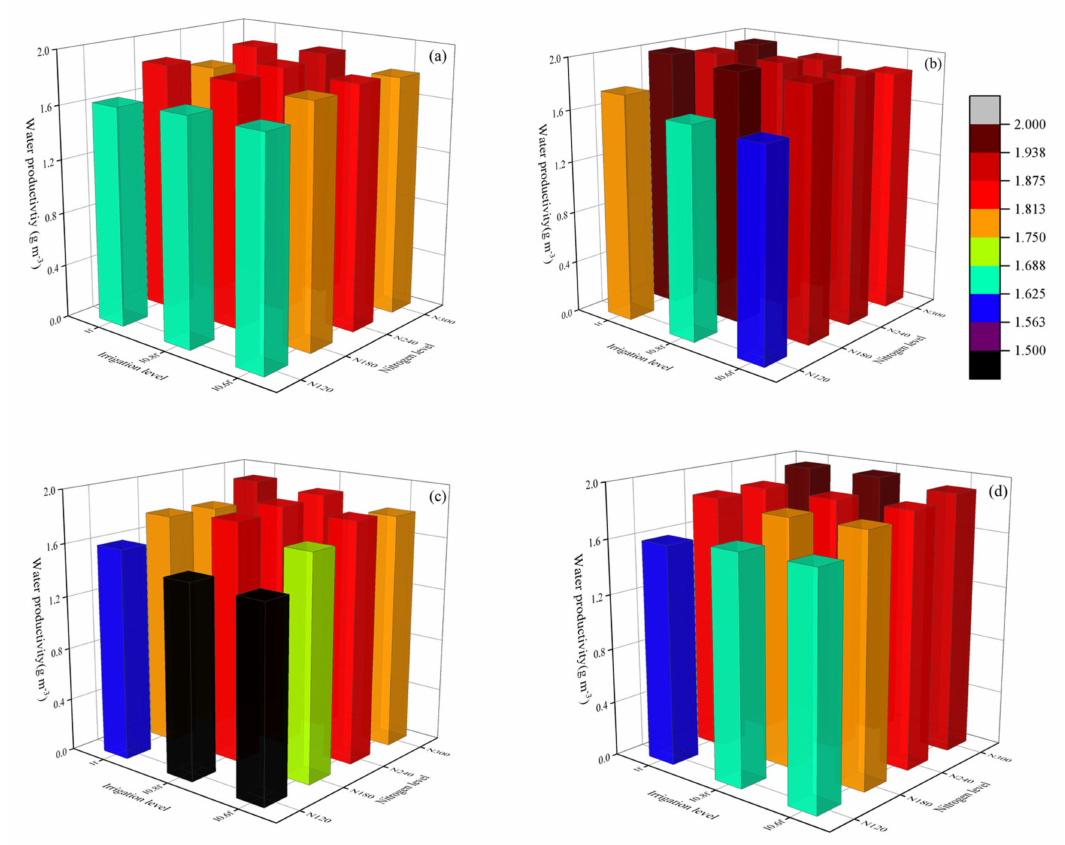
Figure 6. Water productivity of winter wheat in the season of ( a ) 2014–2015, ( b ) 2015–2016, ( c ) 2016–2017, and ( d )